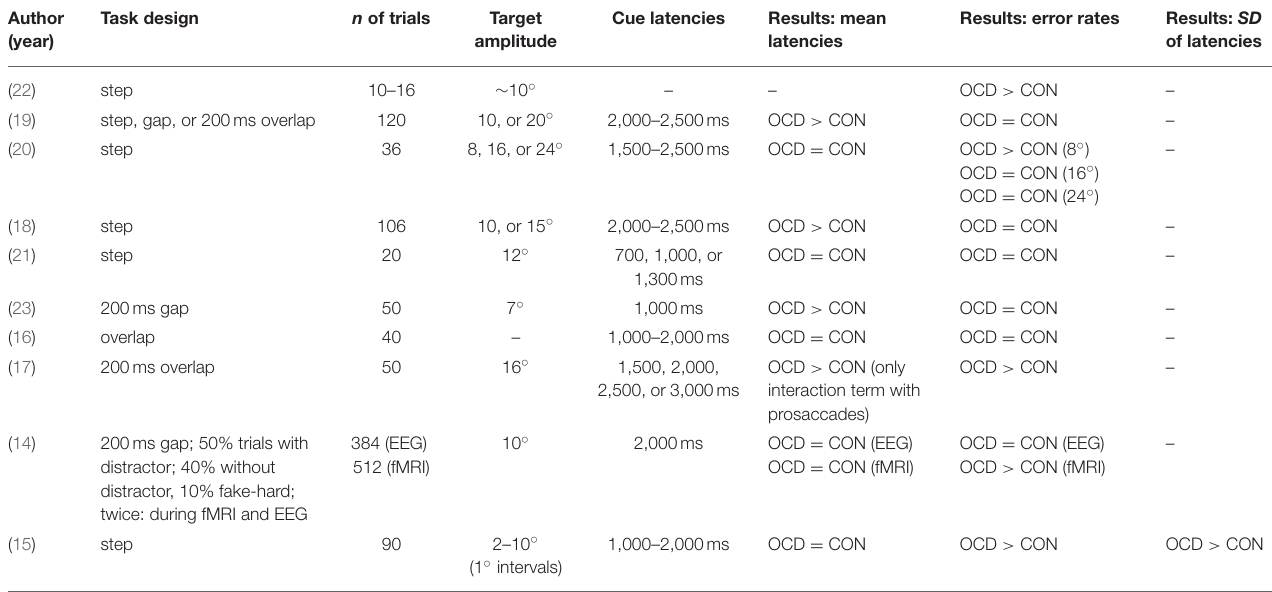
TABLE 3 | Task characteristics and results of the 10 studies included in the